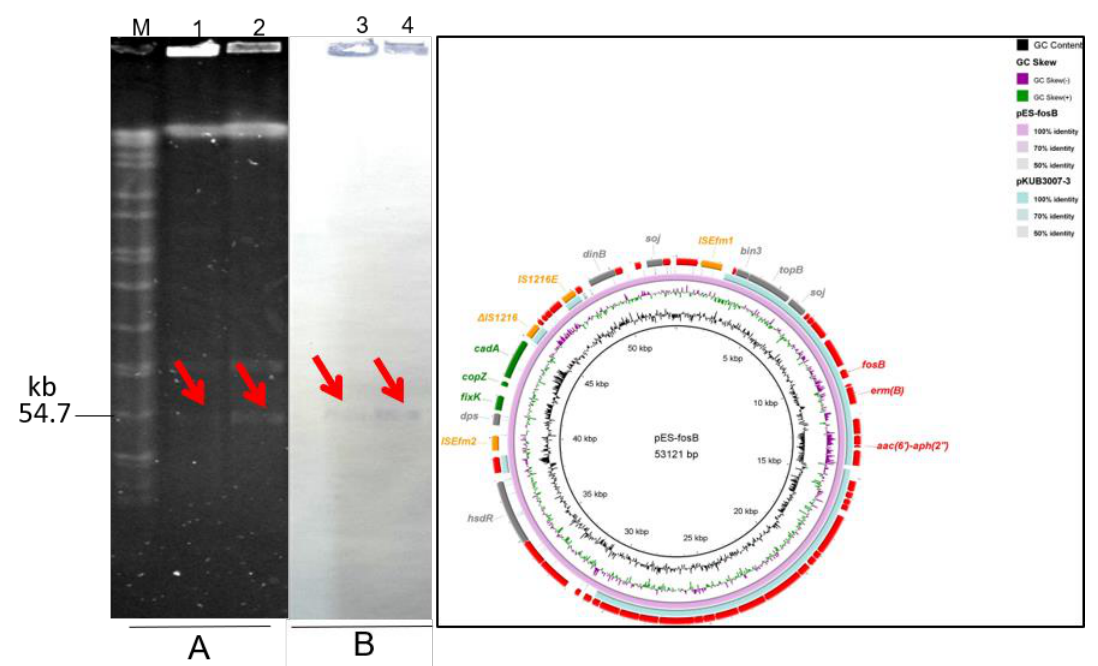
Figure 2. The location of fosB in wild-type E. faecalis strains ES-1 and ES-2. ( A ) S1-PFGE of fosB -carrying wild-type E. faecalis strains ( B ) the corresponding Southern hybridization using the fosB -specific probe. Lane M, marker H9812; lanes 1 and 2 represent S1-PFGE patterns of isolates ES-1 and ES-2, lanes 3 and 4 represent southern blot patterns of fosB gene in ES-1 and ES-2. ( C ) The genetic contents of plasmid pES- fosB . Circular representation of alignments between reference fosB carrying generated by Blastn and visualized by BLAST Ring Image Generator. Table 1. Characterization of fosB positive strains and their transconjugants.